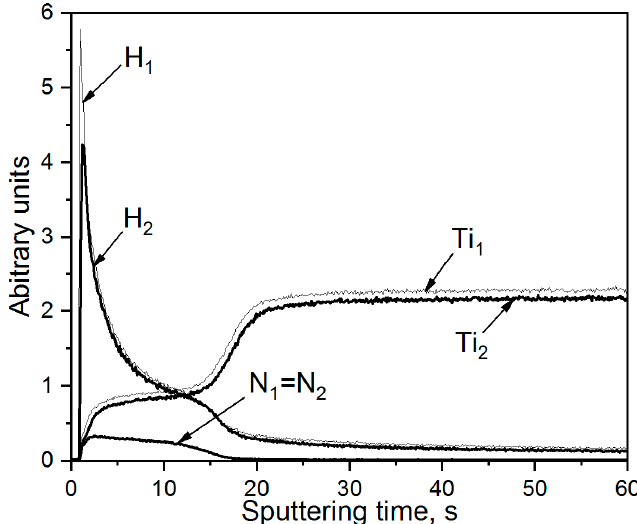
Figure 10. Element distribution profiles in the TNSMC specimens with a δ —TiN coating immedi- ately after cathode hydrogenation in a physiological saline solution (H 1 , Ti 1 , N 1 ) and after holding (430 h) at room temperature in air environment (H 2 , Ti 2 , N 2 ).